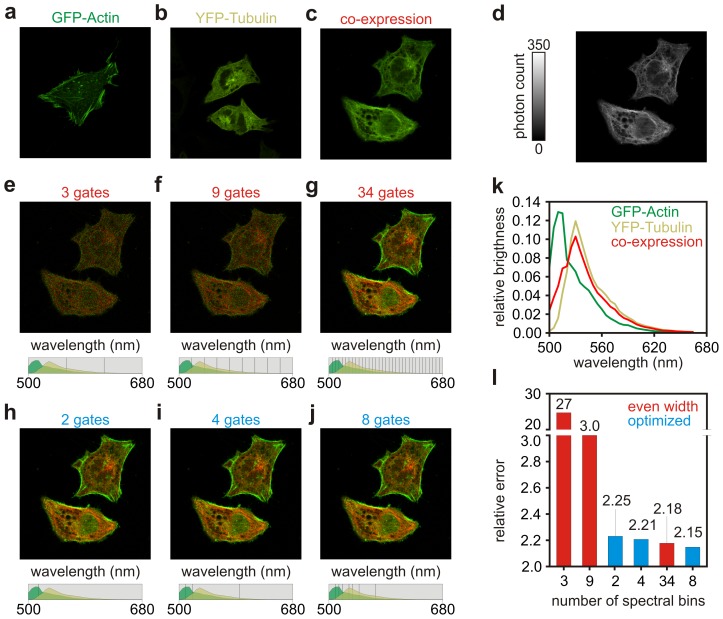
Spectral unmixing of fluorescent proteins.True color images of cells expressing EGFP-Actin (a), EYFP-Tubulin (b), both proteins (c) and total photon count per pixel (d) for the latter. Spectral unmixing was used for different gating schemes (e–j) for gates of even width with 3 (e), 9 (f) and 34 (g) gates and for optimized gates of 2 (h), 4 (i) and 8 (j) gates. The spectra gating scheme is displayed at the bottom of the panels with the reference spectra (k) overlaid for comparison. In green the signal recovered for GFP-Actin and in red the signal estimated for YFP-Tubulin. The comparison of the best achievable F-values measured experimentally demonstrate the positive impact of gating optimization and the trend to provide more precise results at increasing channel number (l).